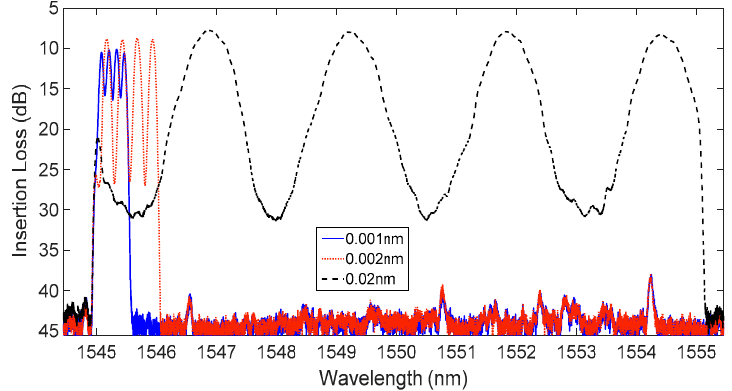
Figure 8. Measured optical spectra for 2.5 GHz (0.02 nm), 0.25 GHz (0.002 nm), and 0.125 GHz (0.001 nm) continuous sine waves.